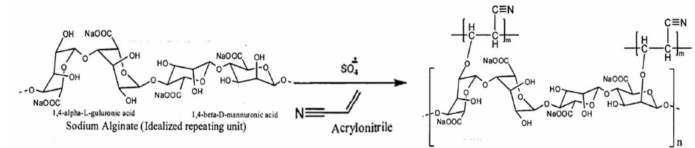
Figure 6. Grafting copolymerization reaction of sodium alginate with